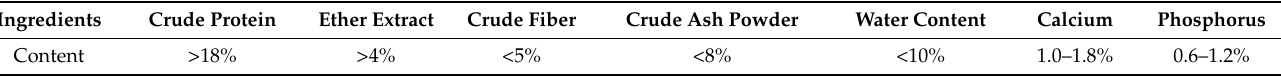
Table 3. The main nutritional composition of a normal